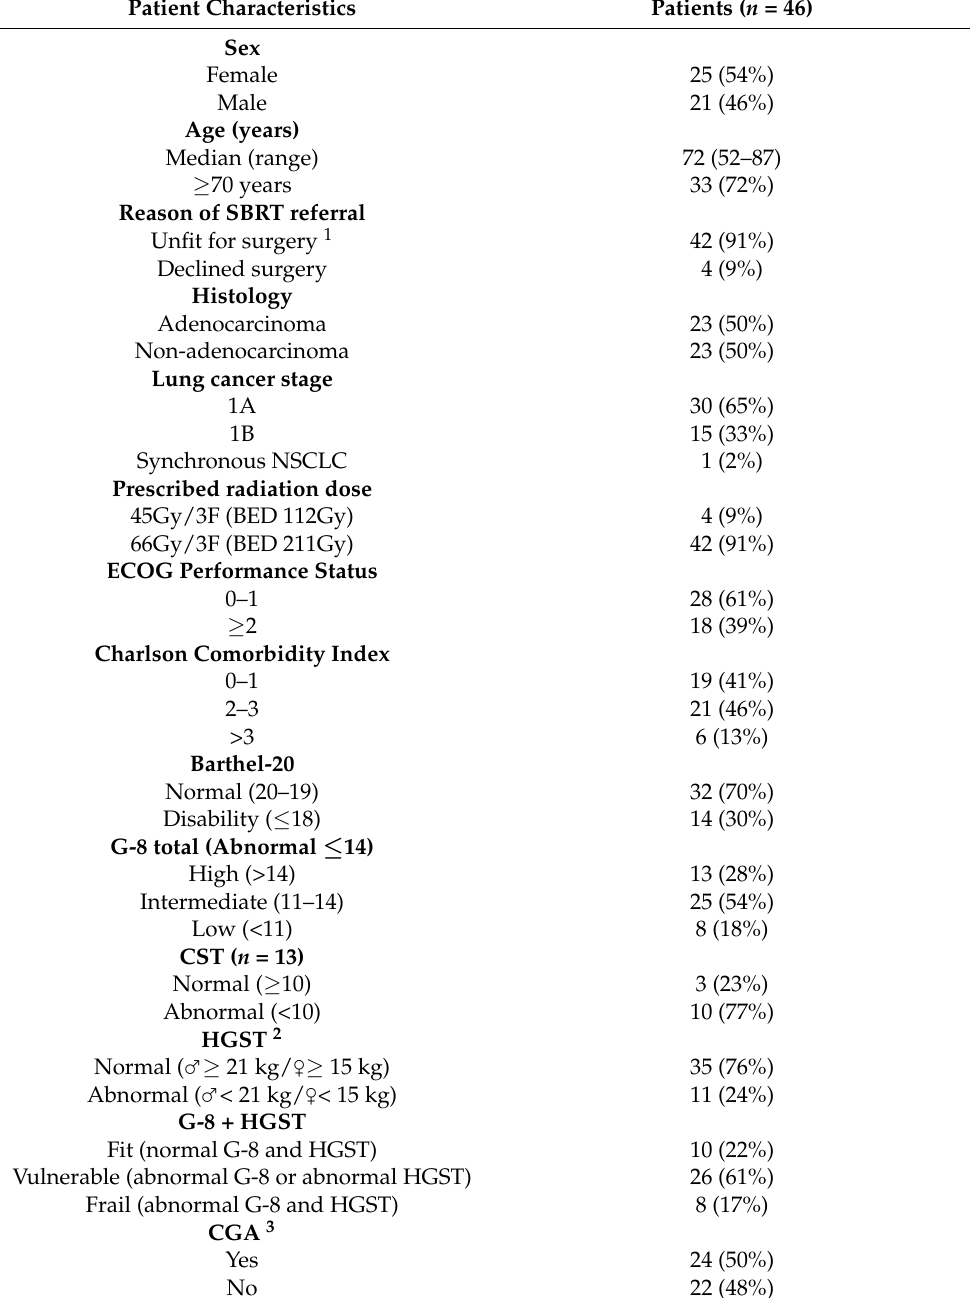
Table 1. Baseline characteristics of patients with localized non-small cell lung cancer who were treated with stereotactic body radiation therapy.